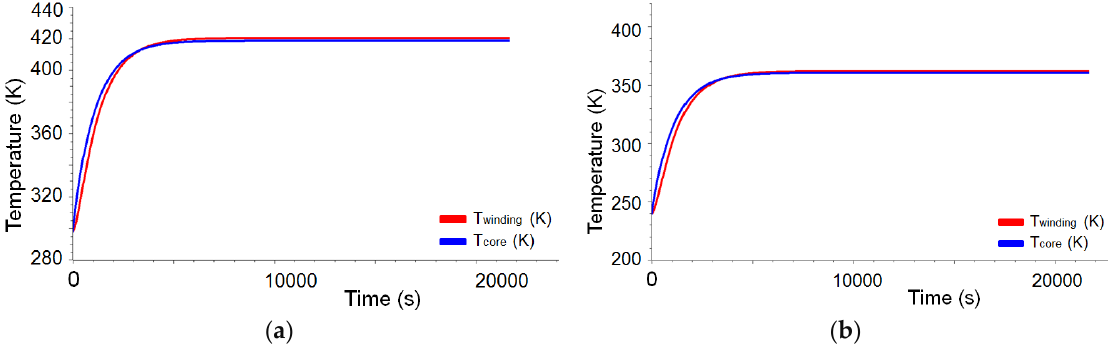
Figure 20. Temperature rise in 100,000 RPM PMSM machine for ( a ) ground operation and ( b ) high altitude operation.